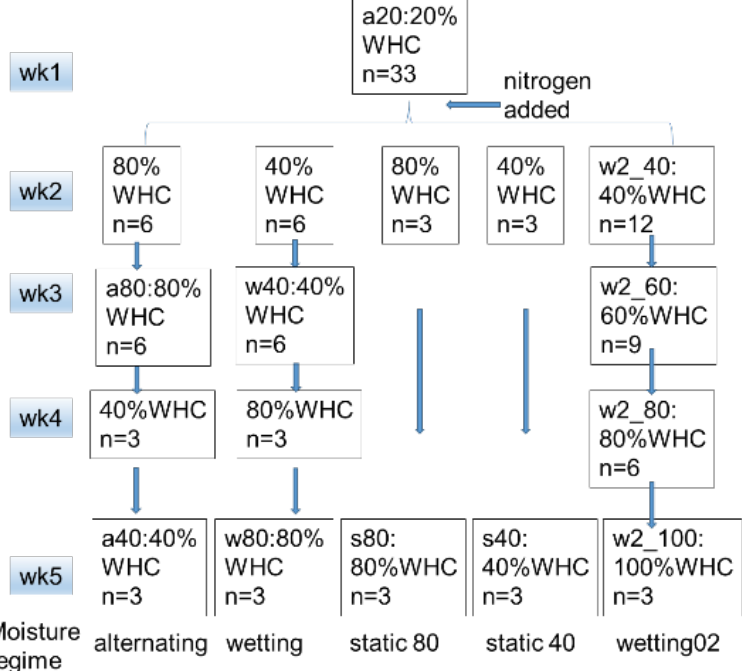
Figure 1. The overview of experimental design and workflow. a20, 20% WHC for one week; a80, 80% WHC for two weeks; a40, 40% WHC for two weeks; w40, 40% WHC for two weeks; w80, 80% WHC for two weeks; s40, 40% WHC for four weeks; s80, 80% WHC for four weeks; w2_40, 40% WHC for one week; w2_60, 60% WHC for one week; w2_80, 80% WHC for one week; w2_100, 100% WHC for one week. If the sample processing time is one week, the soil sample is taken on the last day of the week for physicochemical examination and 16S rRNA amplicon sequencing; if the processing time is two weeks, the sample is also taken on the last day, and so on.